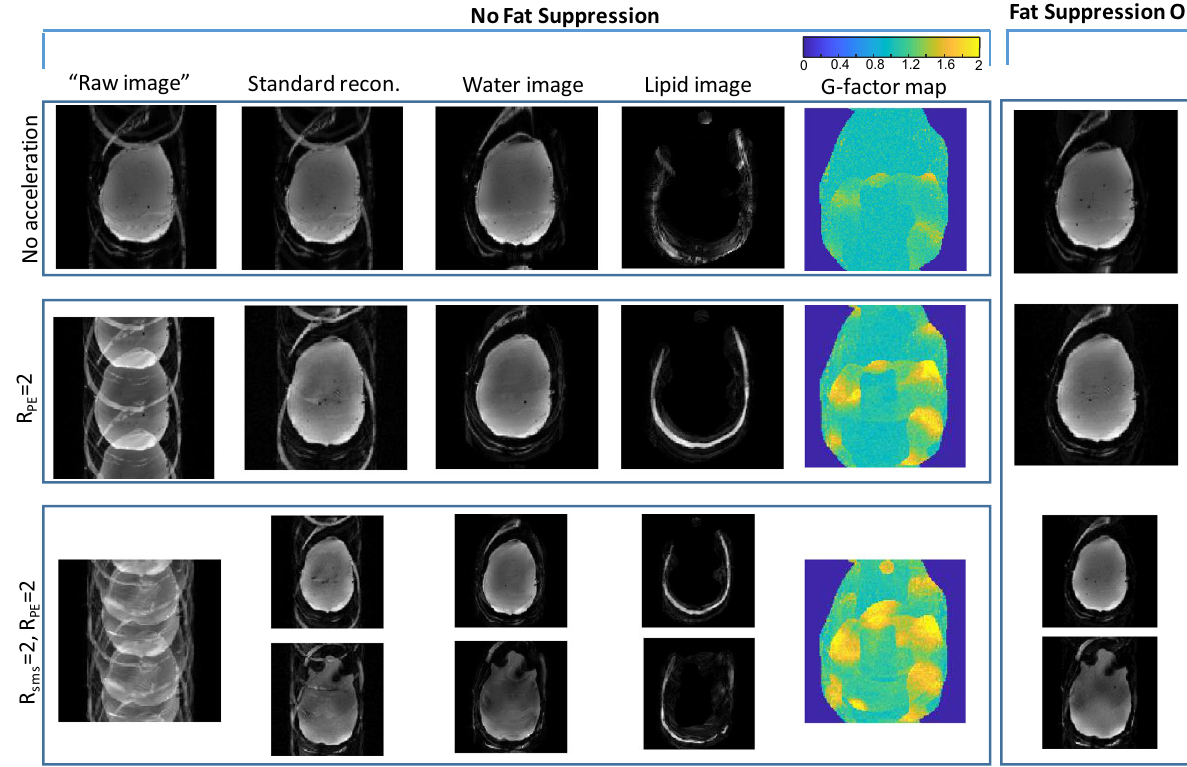
Figure 3. Phantom scanning—combining in-plane acceleration, SMS and lipid-water separation. From top to bottom— R tot = 2 no acceleration (Lipid/Water separation), R tot = 4 (Lipid/Water, R PE = 2), R tot = 8 (Lipid/Water, R PE = 2, R sms = 2). From left to right—“raw image” (FFT applied directly to the acquired image), “standard recon.” (Siemens product reconstruction), images reconstructed with the extended formulation—separate water and lipid images, g-factor maps for the common slice, and the image acquired with fat suppression. The g-factor color-map range is